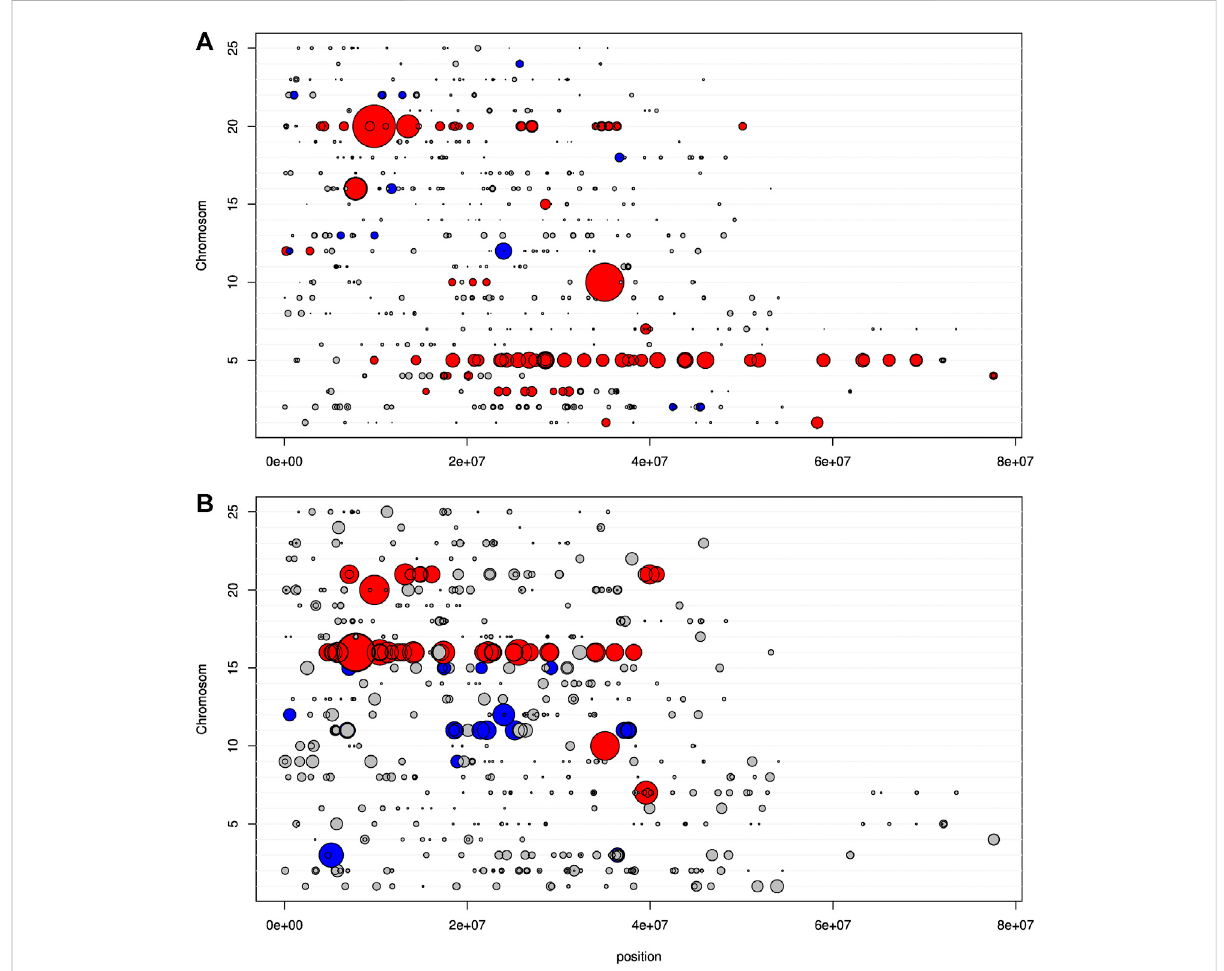
FIGURE 7 Representation on D. rerio chromosomes of the t-statistic expressing the deviation from 1 for the mean genotypic score, calculated on F2individuals.Ingrey,non-signi fi cantdeviation;inblue,signi fi cantdeviationtoward T.souf fi a ;inred,signi fi cant deviation toward P.toxostoma .The size of the dot is proportional to the deviation. (A) Specimens with a size > 2 cm. (B) Specimens with a size of 2